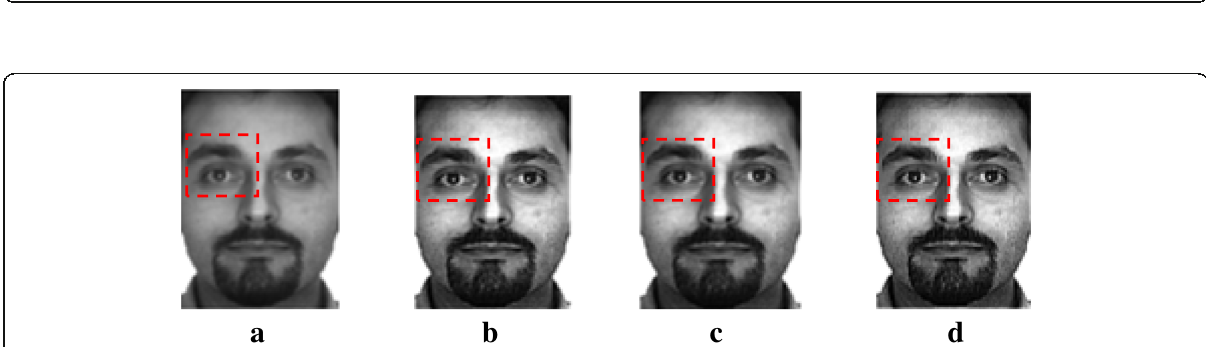
Fig. 5 Qualitative comparison of the different metaheuristic algorithm with our proposed evaluation function on Image 3. a Original. b CSO + proposed evaluation method. c PSO + proposed evaluation method. d GA + proposed evaluation method